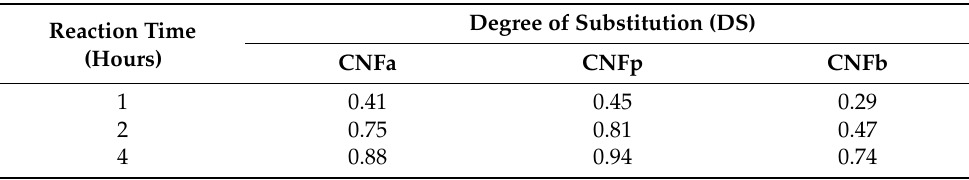
Figure 4. Percentage of CNF modified with respect to the reaction time for CNFa, CNFp, and CNFb. Table 1. Degrees of substitutions (DS) values of the modified CNFs (m-CNFs) based on the reaction